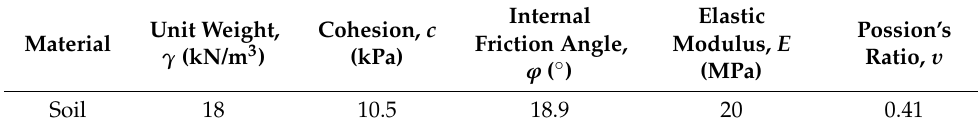
Table 2. The soil